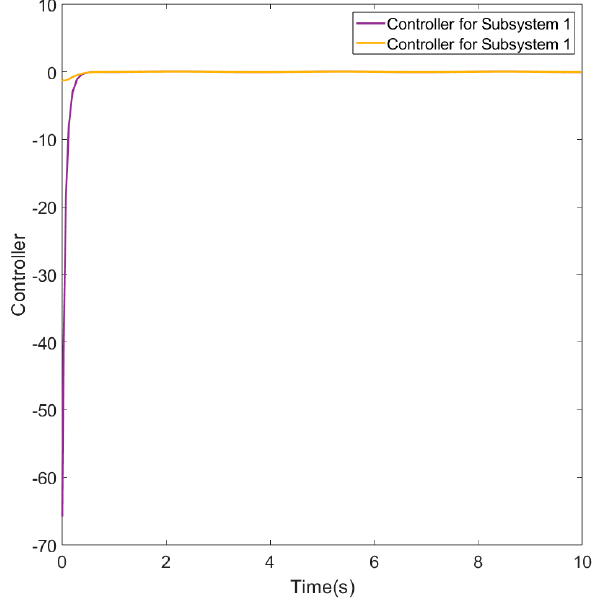
Figure 6. Control signals for Example 1.